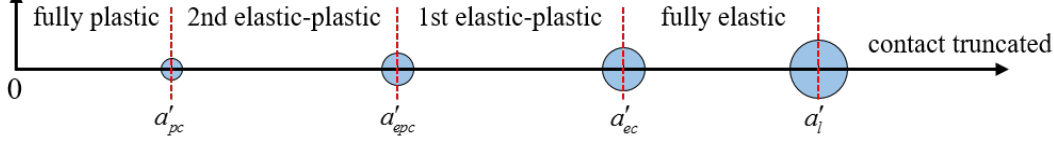
Figure 2. Four stages of asperity deformation.